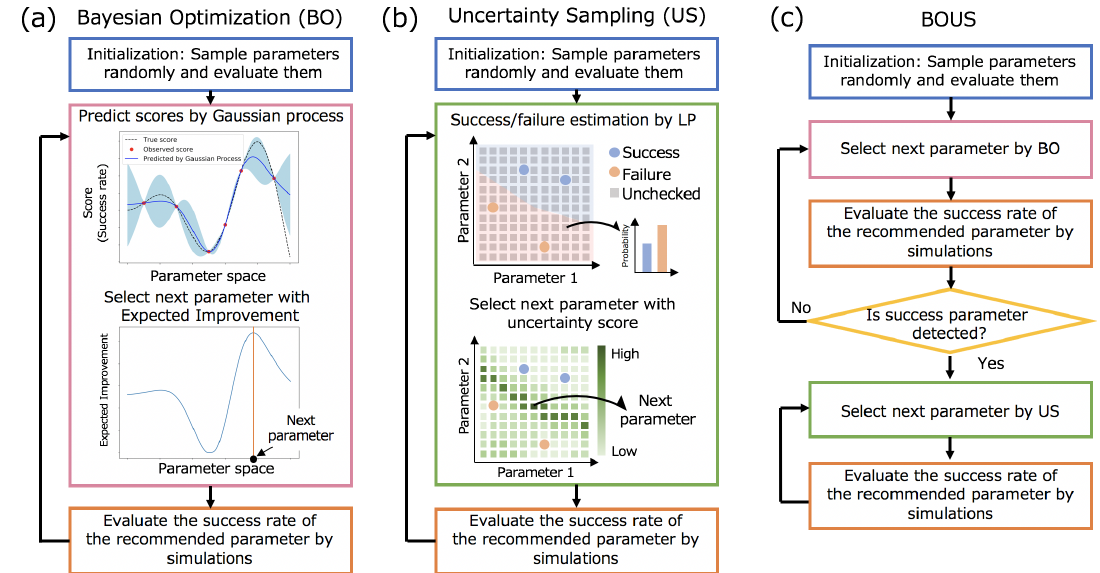
Figure 1. Flowcharts of efficient region search of successful parameters by using Bayesian optimization ( a ) and uncertainty sampling ( b ). ( c ) The combination of Bayesian optimization (BO) and uncertainty sampling (US) (BOUS) for successful parameter region